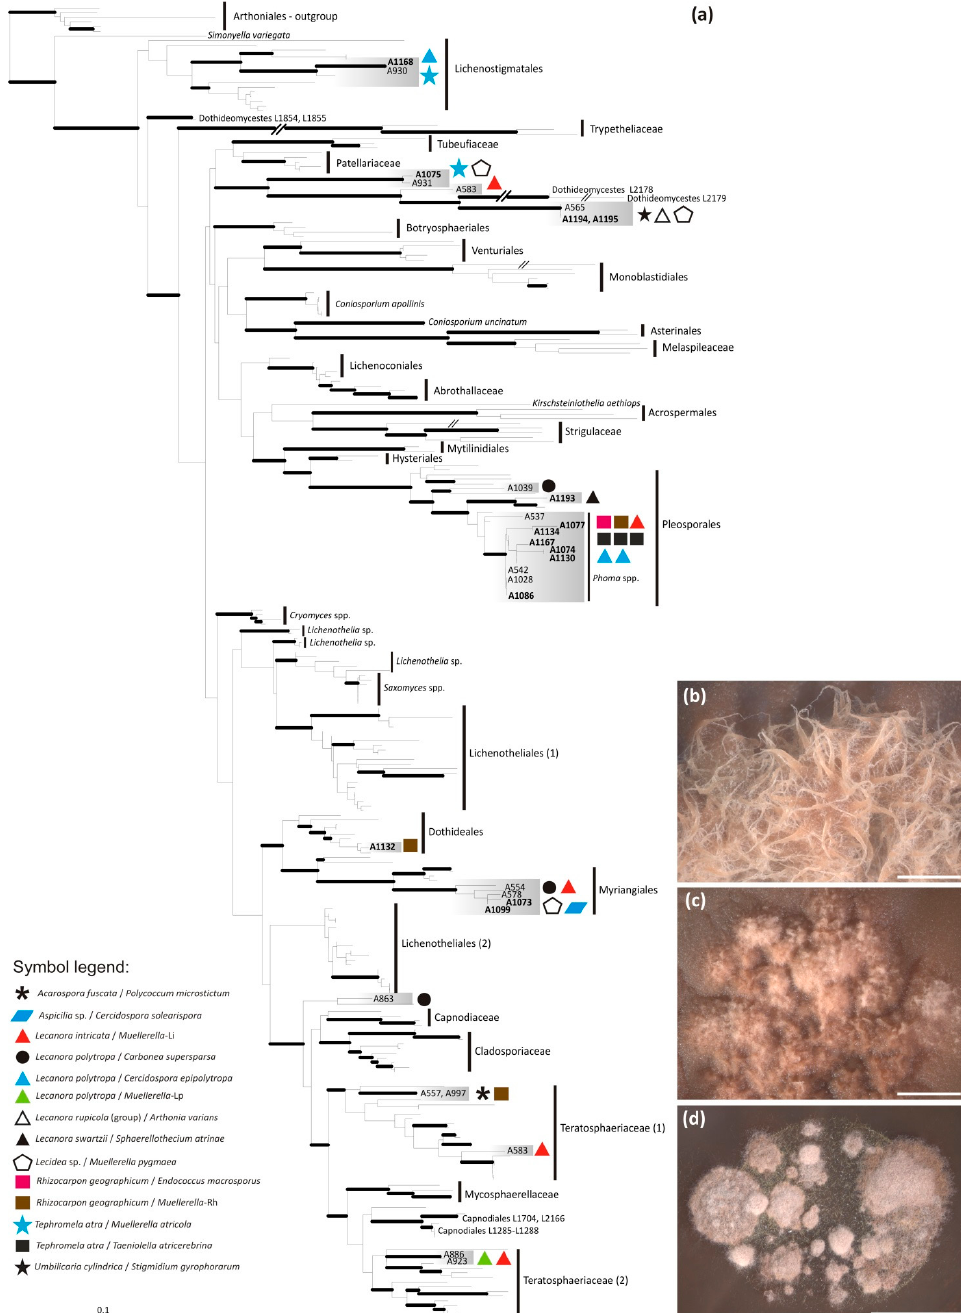
Figure A2. Phylogenetic position of fungal strains belonging to the class Dothideomycetes ( a ) and habit of representative cultured strains: ( b ) A1077 (Pleosporales, Phoma clade); ( c ) A1086 (Pleosporales, Phoma clade); ( d ) A1168 (Lichenostigmatales). The symbol legend reported describes the identity of the original samples from which the fungi were isolated: lichen species name/lichenicolous fungus species name infecting that lichen thallus. The isolated strains are reported with their DNA ID number; newly characterized strains are in bold; strains already characterized in Muggia et al. [9] and included in the analyses of growth media are not in bold. The nomenclature of the clades follows Muggia et al. [9]. Fully supported branches (bootstrap support = 100%) are in bold. Scale bar = ( b ) 2 mm, ( c ) 4 mm, ( d ) 5 mm.